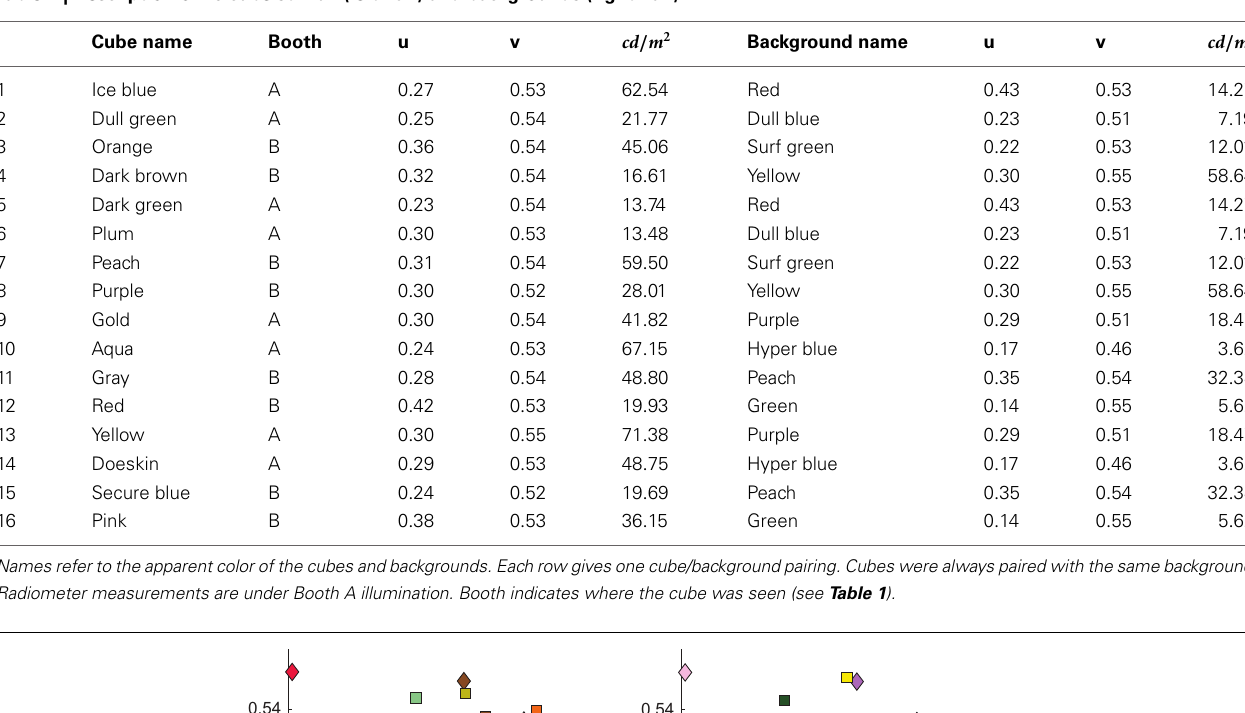
Table 2 | Description of 16 cube stimuli (left half) and backgrounds (right half).